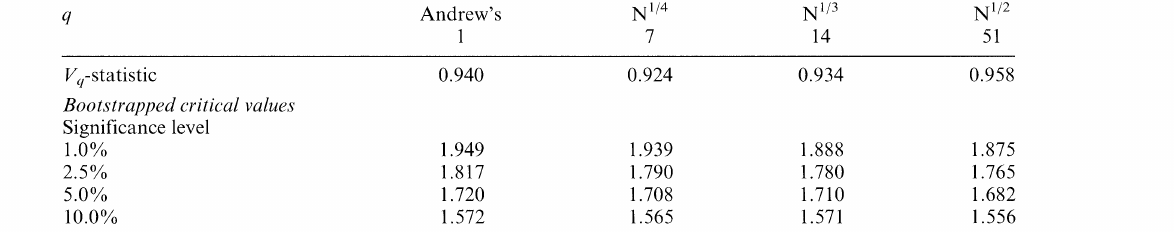
TABLE IV The modified R/S statistic of the daily USD/GRD returns and bootstrapped critical values of the test